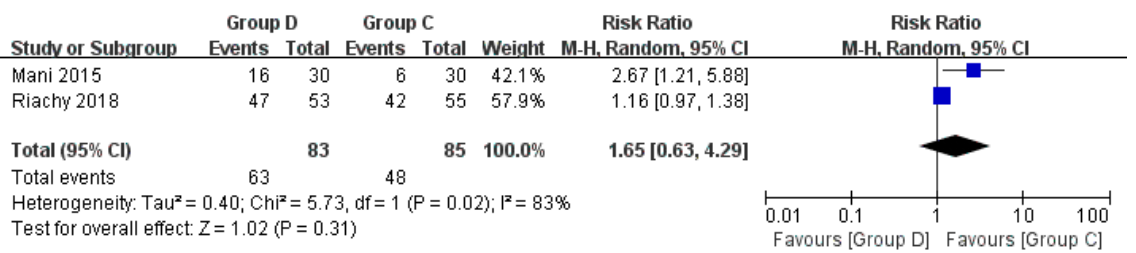
Figure 11. Forest plots comparing the effects of dexmedetomidine and control group on cough [27,31].